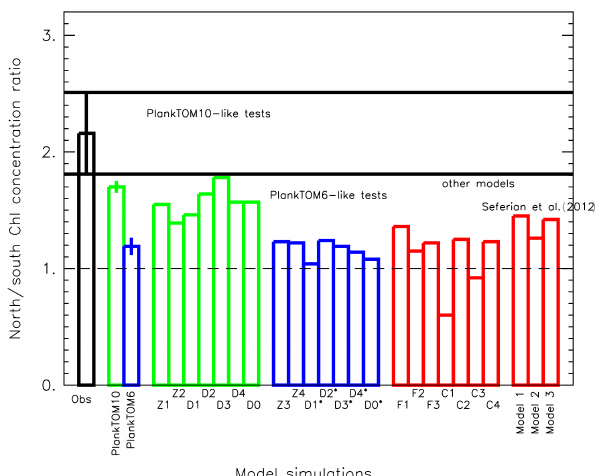
Figure 11. North / south ratio of surface Chl concentration in the Pacific Ocean. Observations are from SeaWiFS. Model re- sults in green correspond to model runs with slow-growing zoo- plankton: PlankTOM10 (includes macrozooplankton), (Z1) Plank- TOM6 plus macrozooplankton, (Z2) PlankTOM6 with mesozoo- plankton parameterised like macrozooplankton, (D0–D4) Plank- TOM10 with no dust deposition or with dust fields from Mahowald et al. (2009), Tegen et al. (2004), Ginoux et al. (2001) and Ma- howald et al. (2003), respectively. Model results in blue correspond to model runs without slow-growing zooplankton: PlankTOM6, (Z3) PlankTOM10 minus macrozooplankton, (Z4) PlankTOM10 with macrozooplankton parameterised like mesozooplankton, and (D0 ∗ –D4 ∗ ) as above with PlankTOM6. Results from (F1–F3) are model simulations available through the MARine Ecosystem Model Intercomparison Project and (C1–C4) the Climate Model Intercom- parison Project 5 (Arora et al., 2011; Dufresne et al., 2013; Gior- getta et al., 2013; Jones et al., 2011). Results from Séférian et al. (2013) mainly differ through their representation of sub-grid- scale processes, with improvements in the representation of sum- mer mixed-layer depth from Models 1 to 3. All data are averaged between 30 and 55 ◦ latitude in both hemispheres: 140–240 ◦ E in the north and 140–290 ◦ E in the south, as highlighted in Fig.